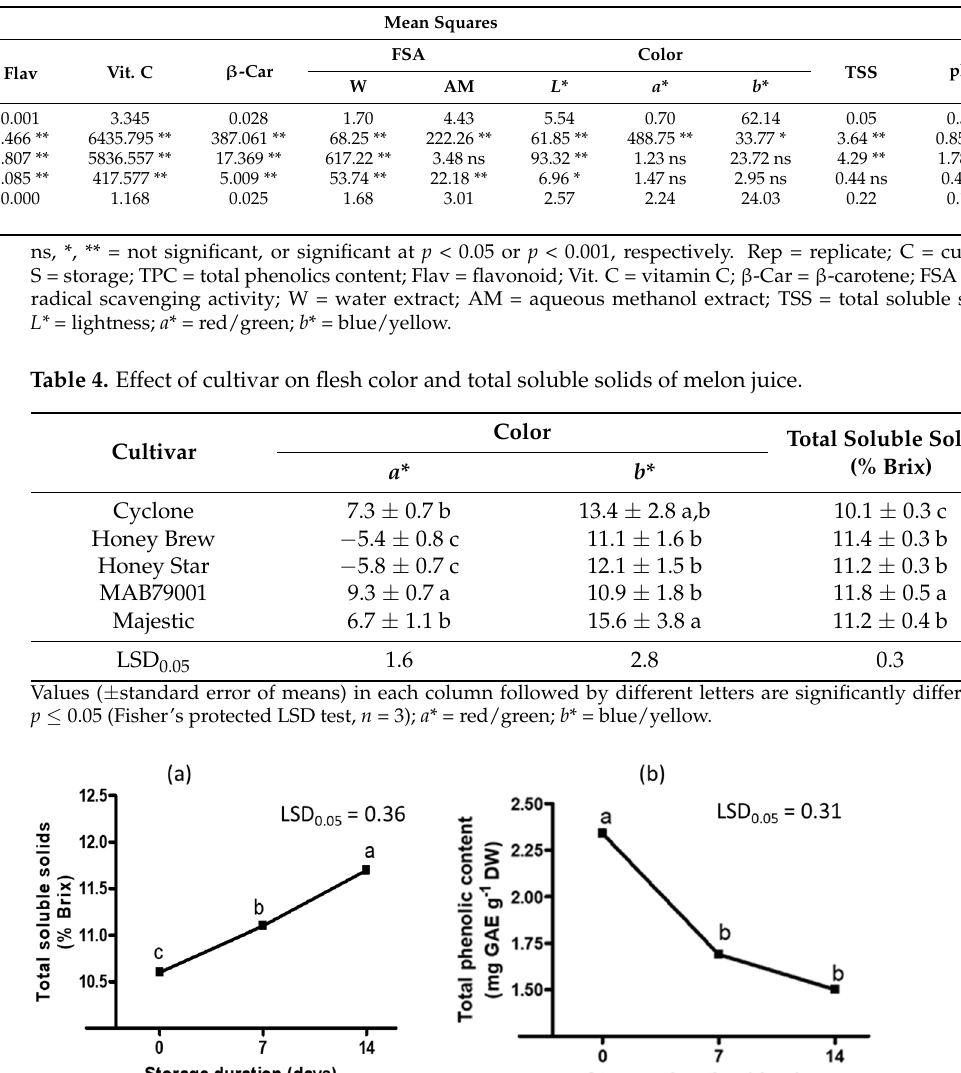
Figure 7. Interaction effect of sweet melon cultivars and storage duration on fruit color ( a ) and fruit juice pH ( b ). Points on lines with different letters in each graph are significantly different at p ≤ 0.05 (Fisher’s protected LSD test, n = 3). L * = lightness. All cultivars exhibited a decrease in vitamin C concentration with an increase in stor- age duration (Figure 8). At the end of the 14 days of storage, cv. Honey Star had the great- est decrease (46%) in vitamin C (Table S4). Cultivar Cyclone consistently had the highest vitamin C content during storage while cvs. Honey Brew and Honey Star had the lowest concentrations (Figure 8). A decline in vitamin C content of non-netted green-fleshed and orange-fleshed sweet melons collected from the field, and the non-netted green-fleshed Honey Brew, had the lowest concentration on day 17 of storage [14]. In the current study, an increase in storage duration resulted in a decline in the vitamin C content of sweet melons regardless of the cultivar type (Table S4). During postharvest storage, β -carotene concentration may remain stable, or decrease, depending on storage temperature [31]. In the current study, fruit were stored at the same temperature. A decrease in β -carotene content occurred in cantaloupe melons with an increase in postharvest storage duration (Figure 8, Table S4). The β -carotene concentration of cvs. Honey Star and Honey Brew, although the lowest, remained fairly stable during postharvest storage. Cultivar and flesh color influence β -carotene concentration among the sweet melon fruit while storage pe- riod and cultivar determine its retention. Unlike vitamin C and β -carotene concentrations, flavonoid content of fruit increased during storage in almost all cultivars (Figure 8; Table S4). Cultivar MAB79001 had the highest increase in flavonoid concentration (Table S4),